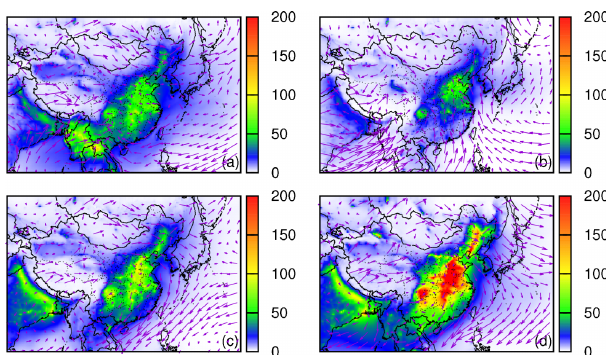
Figure 6. Seasonal variation of predicted PM 2 . 5 and wind vectors: (a) spring, (b) summer, (c) fall, and (d) winter. Units are µgm − 3 .